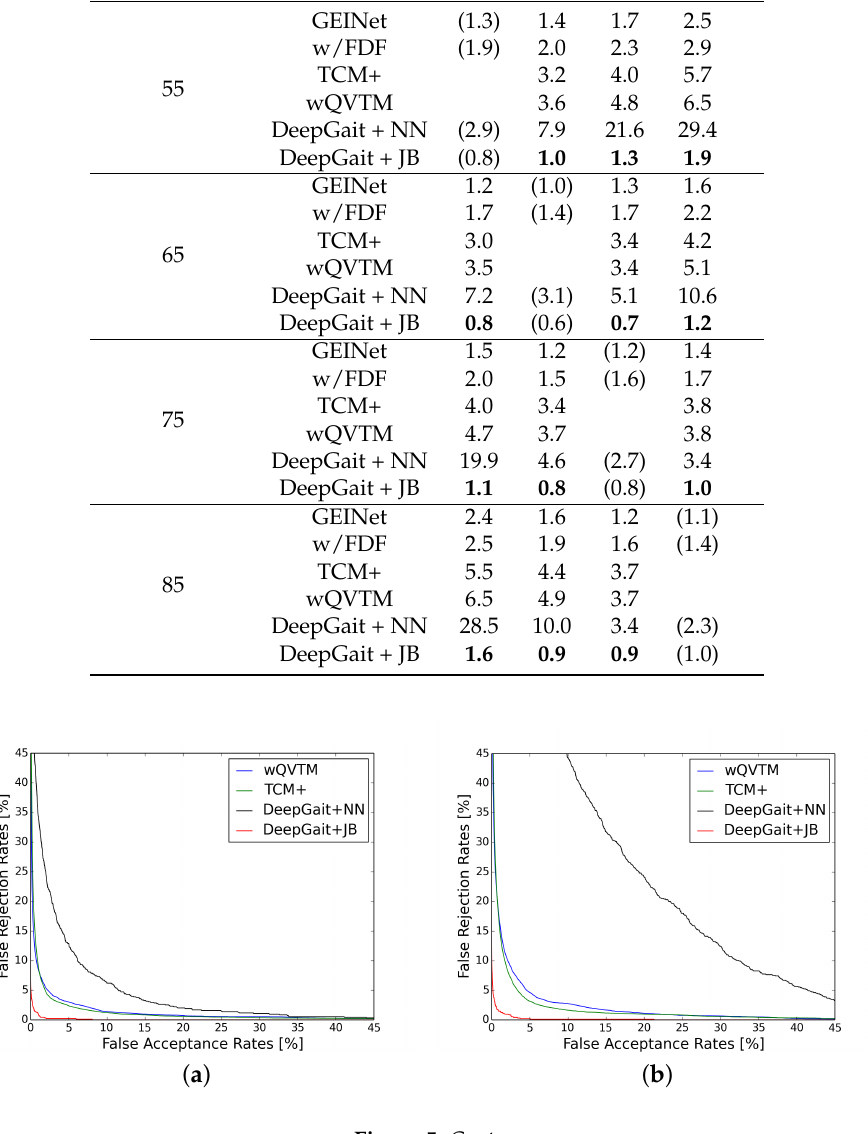
Table 3. Comparison of EERs (%) with other existent methods under different cross-view settings. Gallery View